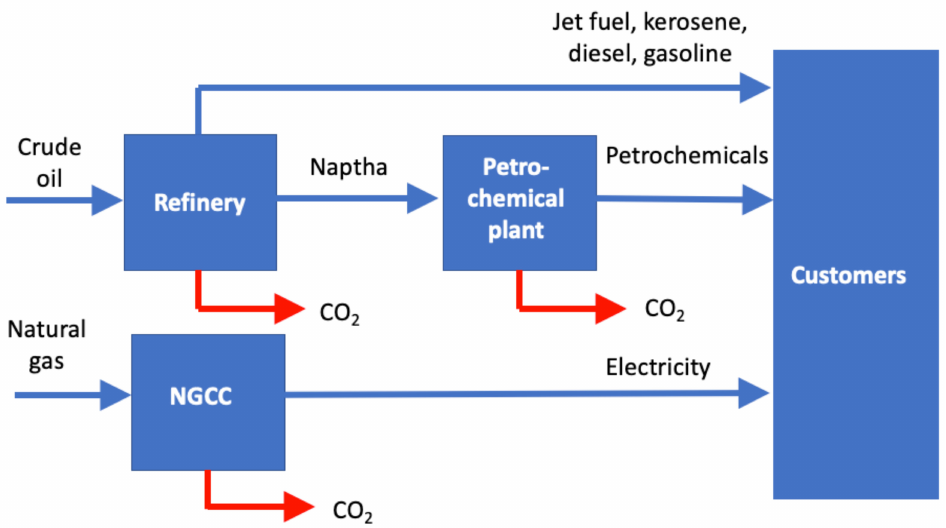
Figure 12. Current nexus between the power, refining, and petrochemical industries in Singapore.